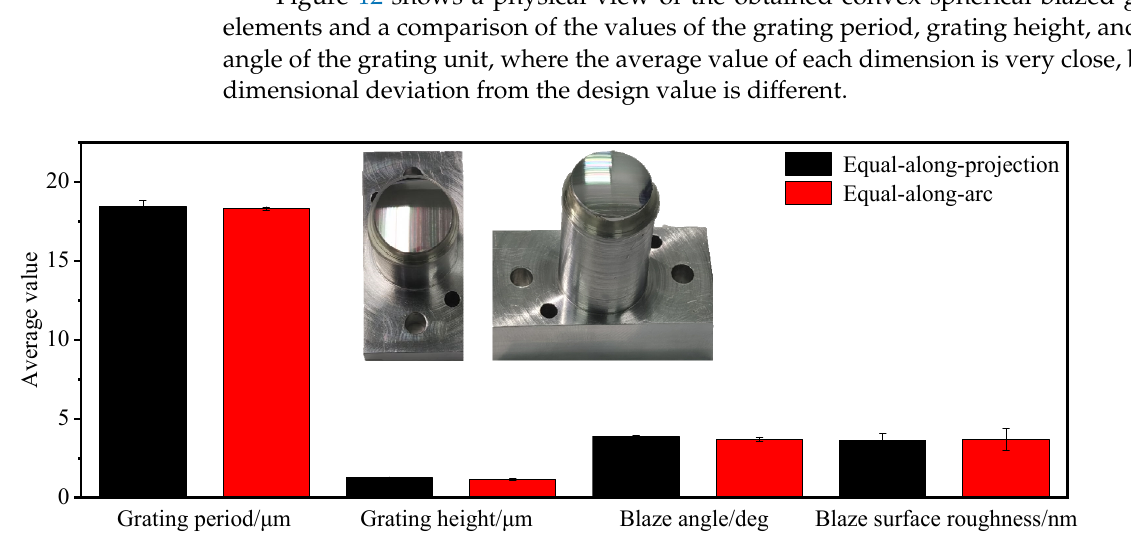
Figure 12. Comparison of grating period, grating height, blaze angle, and blaze surface roughness of blazed grating at different layouts.